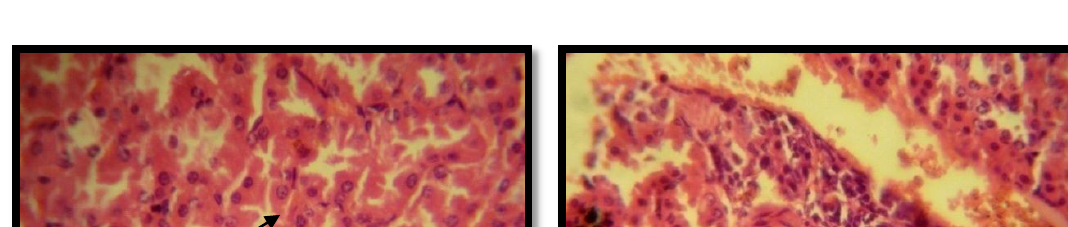
Figure 2: Liver of mouse treated with 16mg/kgbw of pentoxifylline for1month showing aggregation of mononuclear cells beside the central vein ( ) (H&EX40).